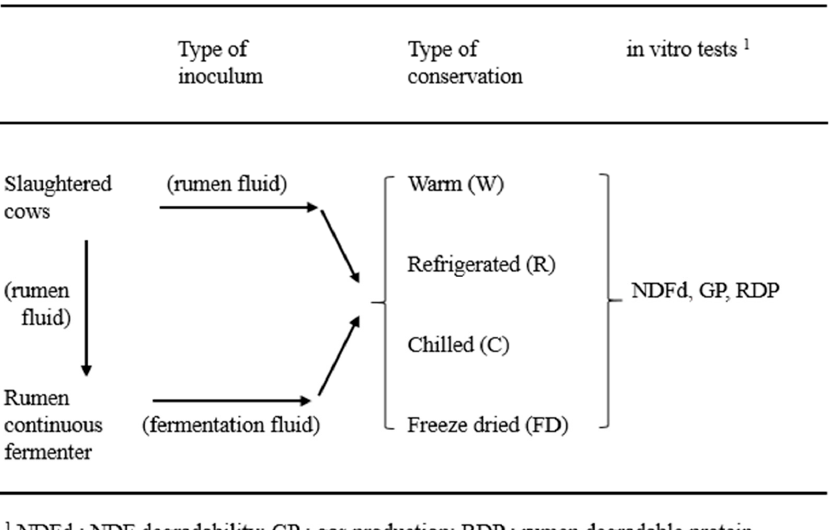
Figure 1. Schematic representation of the trial